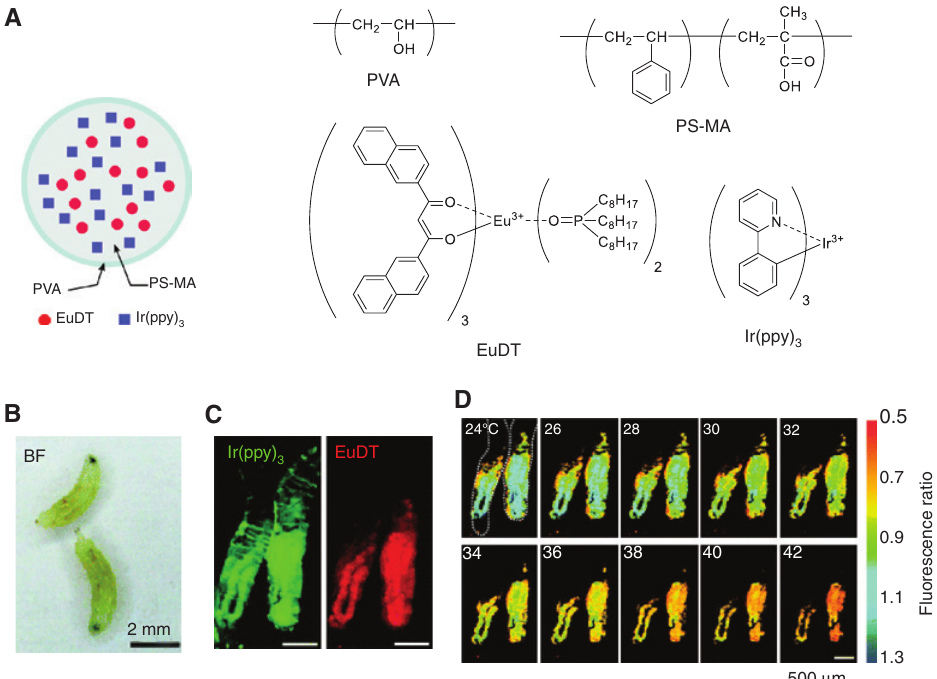
Figure 14: Thermography of fruit fly larvae using polystyrene-based ratiometric fluorescent nanoparticle thermosensor (PS-RNT). (A) Schematic illustration of PS-RNT and the chemical structures of the components of PS-RNT (i.e. PVA, PS-MA, EuDT, and Ir(ppy) (B) Bright field (BF) image of two fruit fly larvae. (C) Fluorescence images of fruit fly larvae obtained under a fluorescence stereomi- = 405–410 nm). The fruit fly larvae were orally dosed with PS-RNT. Left: Ir(ppy) croscope ( λ ex = 615–624 nm). Scar bar = 500 μ m. (D) Thermography of fruit fly larvae using the emission intensity ratio [EuDT/Ir(ppy) channel ( λ em